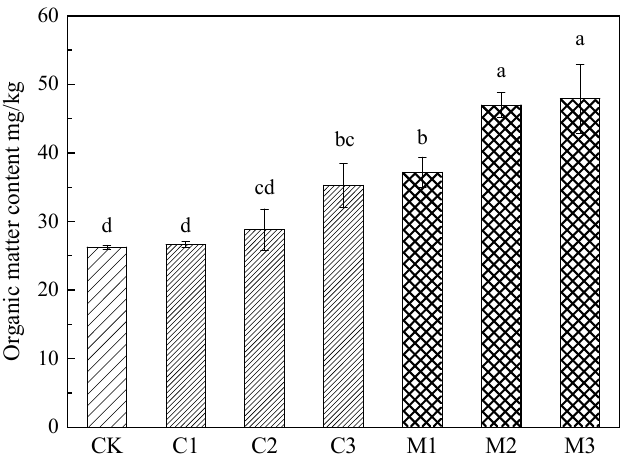
Figure 2. Content of organic matter in tailings treated with